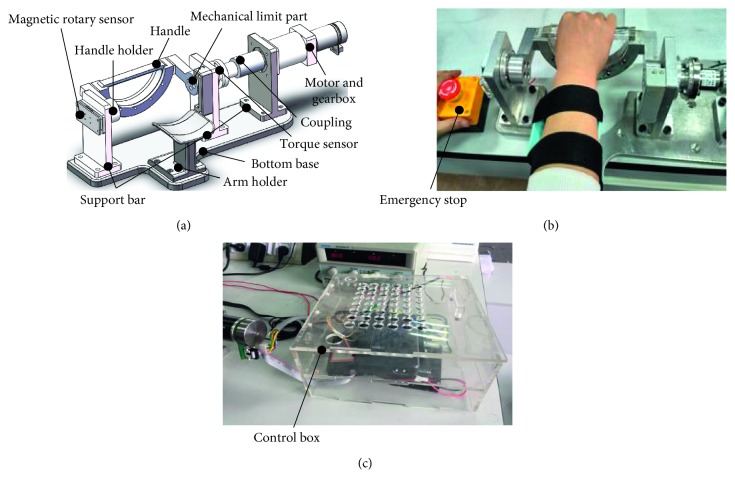
The WReD system. (a) The 3D model, (b) its use on a healthy subject, and (c) the control box.